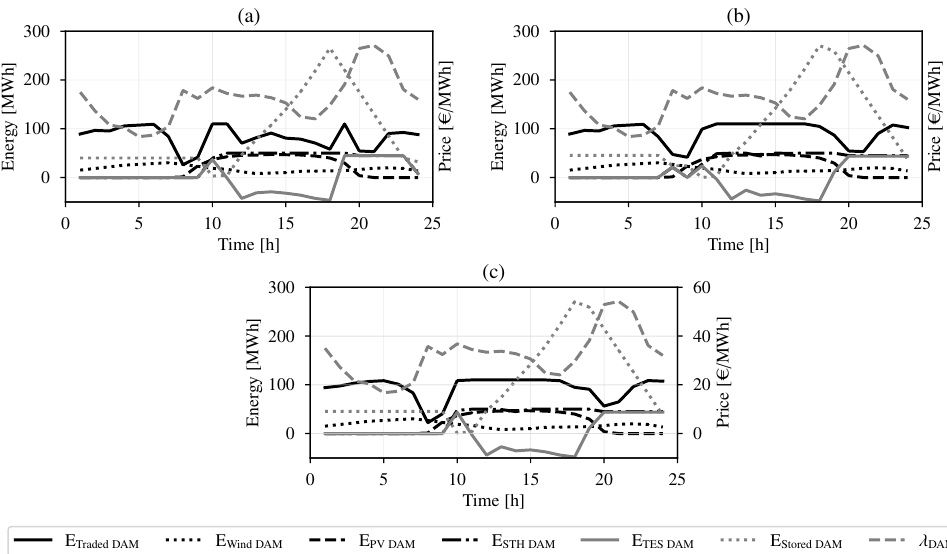
Figure 8. Traded power on a clear day at DAM and IDM in: ( a ) No Coordination; ( b ) VPP with default load profile; ( c ) VPP with three load profiles at zero cost.